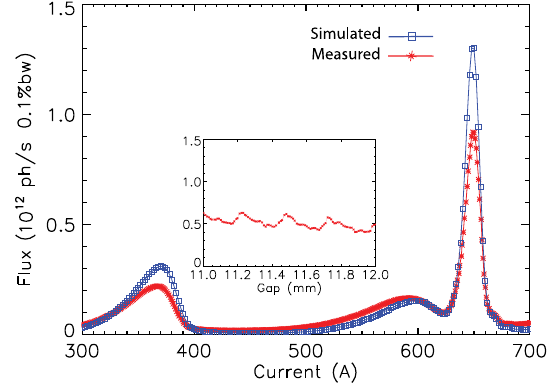
20. Photon flux comparisons at 85 keV. Main: simulated and measured SCU0 photon flux as the main coil current is scanned. Inset: measured photon flux of in-line U33 as the gap is scanned. Inset vertical axis units are the same as the main